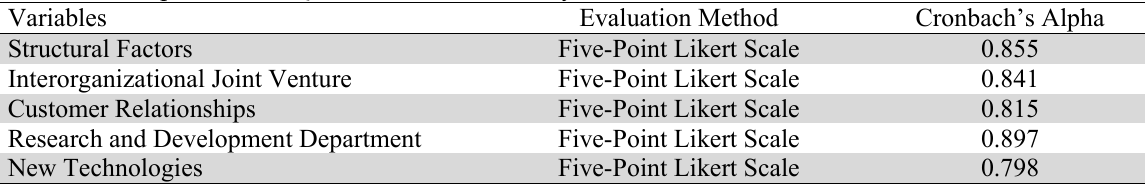
Cronbach’s Alpha for the Questionnaire Reliability Variables